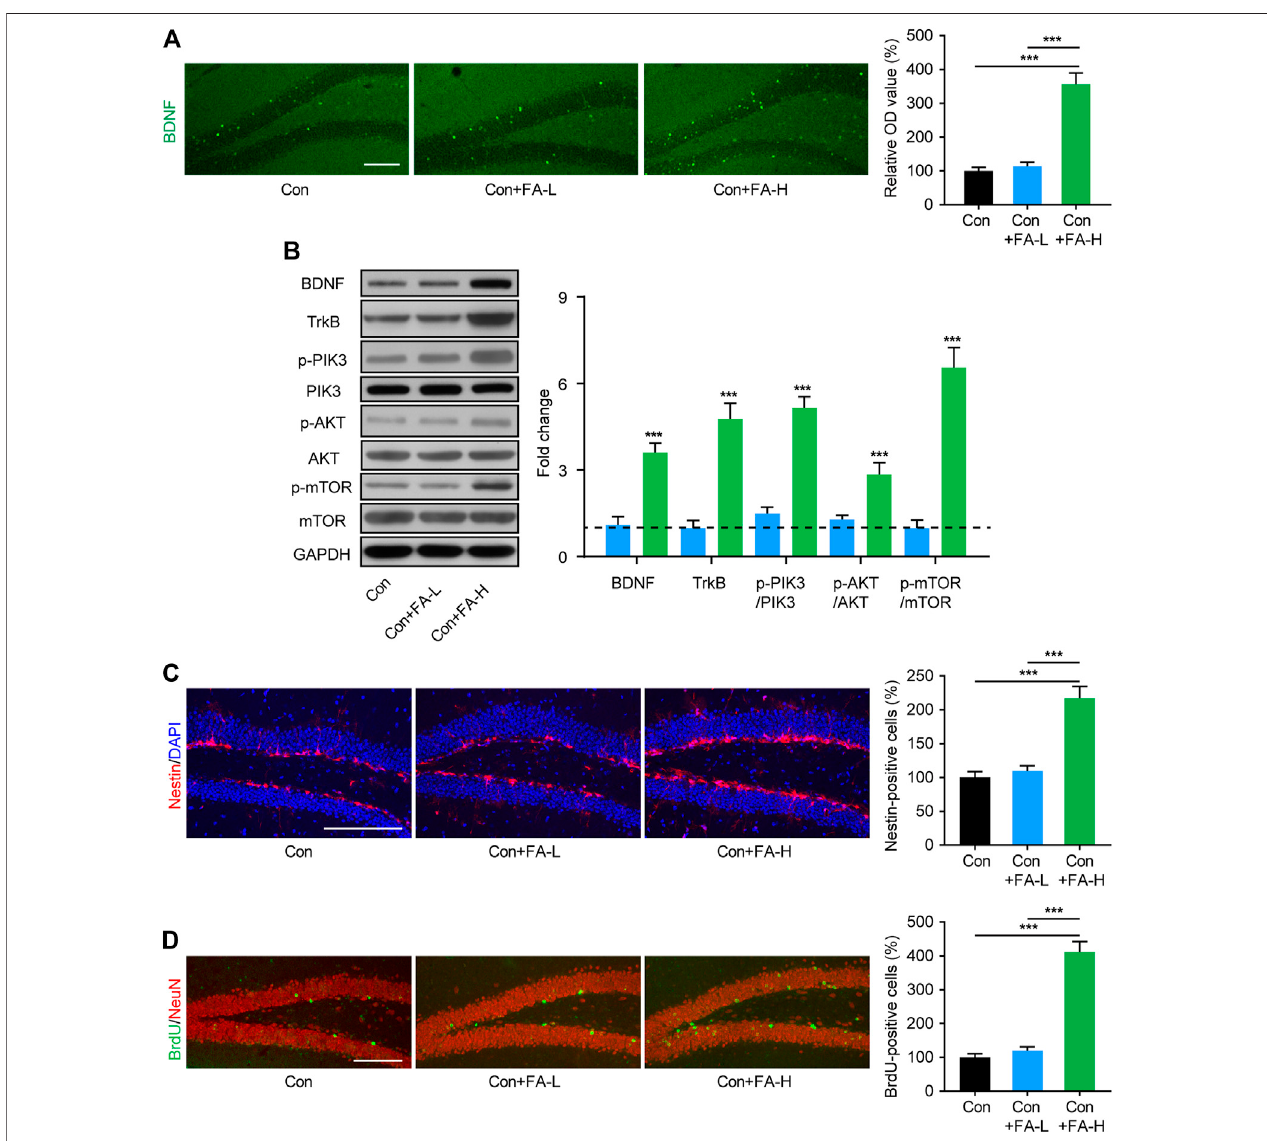
FIGURE 5 | Gestational FA administration promotion of neurogenesis and related molecular expression in postpartum female mice. (A) Representative immunohistochemical images for BDNF (Green) in the hippocampus. Histogram showing average fl uorescence intensity in O.D. value. One-way ANOVA: F (2, 15) (cid:2) 47.97, p < 0.0001. Scale bar (cid:2) 100 μ m. (B) Representative immunoblots and quanti fi cations showing BDNF, TrkB, p-PIK3/PIK3, p-AKT/AKT, and p-mTOR/mTOR expression in the hippocampus. BDNF One-way ANOVA: F (2, 15) (cid:2) 36.87, p < 0.0001. TrkB One-way ANOVA: F (2, 15) (cid:2) 61.06, p < 0.0001. p-PIK3/PIK3 One- wayANOVA:F(2,15) (cid:2) 103.2, p < 0.0001.p-AKT/AKTOne-wayANOVA:F(2,15) (cid:2) 21.66, p < 0.0001.p-mTOR/mTOR One-wayANOVA:F(2,15) (cid:2) 70.2, p < 0.0001. TheCongroupwasnormalized asadottedline,andthestatisticalresultswerecomparedwiththeCongroup. (C) Theimmunohistochemistrystainingandquanti fi cation of Nestin + cells in hippocampus of each group. Nestin (red) and DAPI (blue). One-way ANOVA: F (2, 15) (cid:2) 28.99, p < 0.0001. Scale bar (cid:2) 100 μ m. (D) The immunohistochemistry staining and quanti fi cation of BrdU + cells in hippocampus of each group. BrdU (green) and NeuN (red). One-way ANOVA: F (2, 15) (cid:2) 76.08, p < 0.0001. Scale bar (cid:2) 100 μ m. Data were presented as mean ± SEM. Scale bar (cid:2) 100 μ m n (cid:2) 6 for each group. ** p < 0.01; *** p <